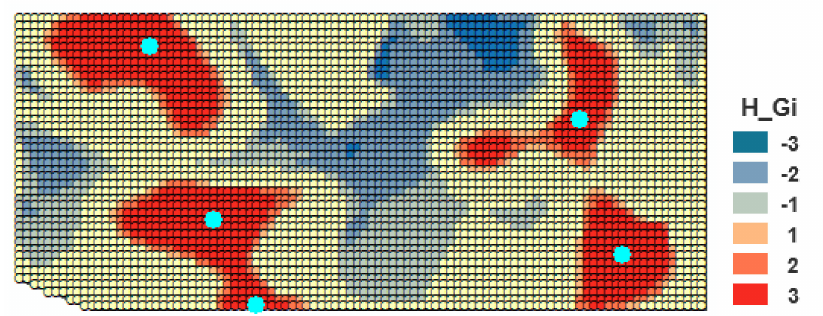
Figure 15. The distribution map for the second dataset using our proposed approach.